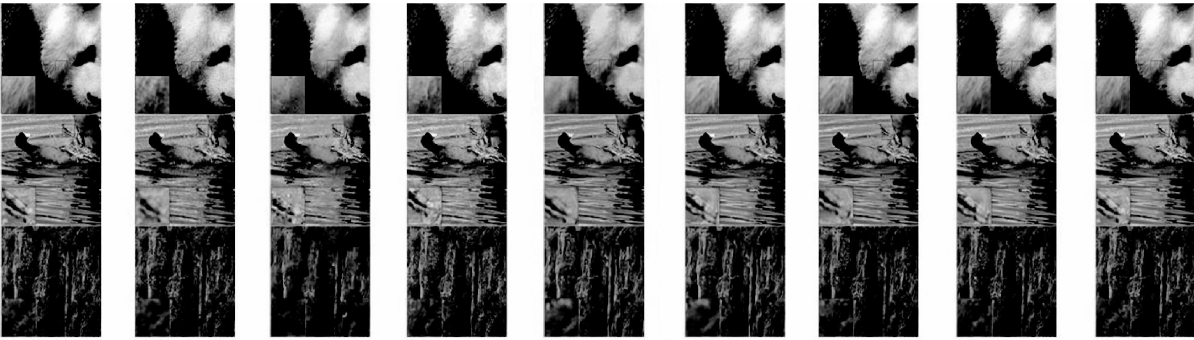
Fig. 3. The denoising effect with different methods. (a) original image (b) noisy (c) BM3D (d) DnCNN (e) MSRResNet-GAN